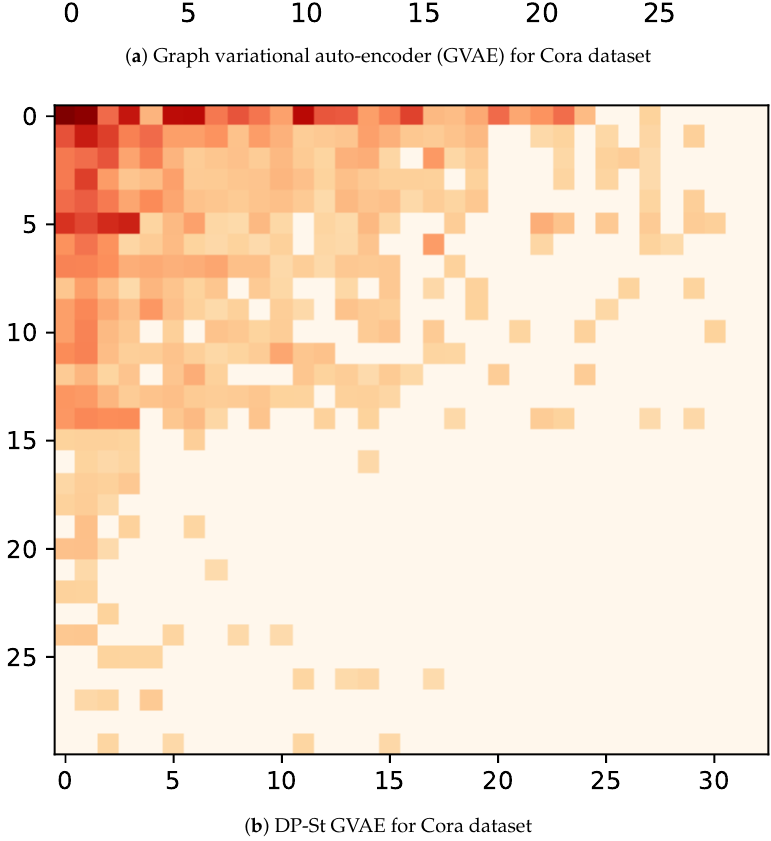
Figure 4. Latent representation visualization for Cora dataset. The horizontal axis is the dimension of the hidden variable, and the vertical axis is the number of nodes. ( a ) the latent variable learned by GVAE. ( b ) the latent variable learned by DP-St GVAE. The darker the higher probability nodes possess the latent